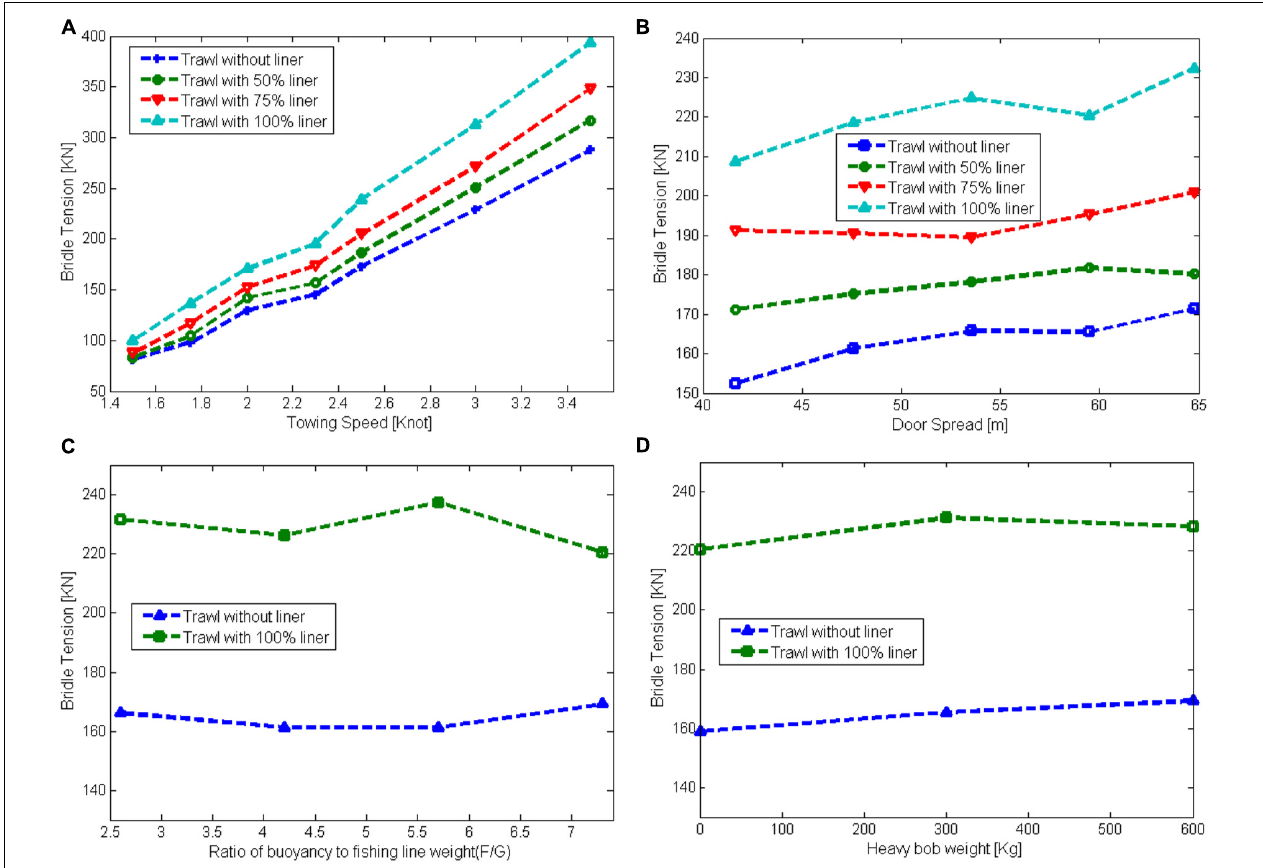
FIGURE 4 | Bridle tension of the different trawls about the (A) towing speed, (B) door spread, (C) ratio of buoyancy to F / G , and (D) heavy bob weight: current data estimated with 95% confidence intervals from the statistical analysis.